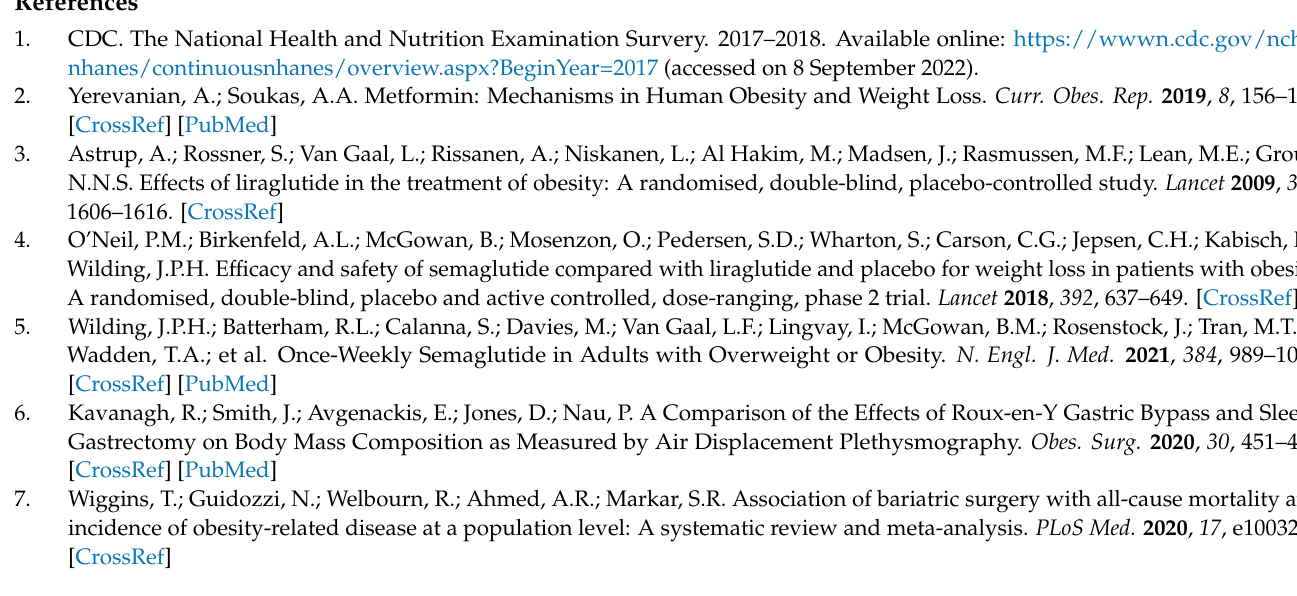
Table S3: Difference in percent change SCFA levels between RYGB and LSG. Table S4: Relationship between dietary intake and short-chain fatty acid levels, pre- and post-bariatric